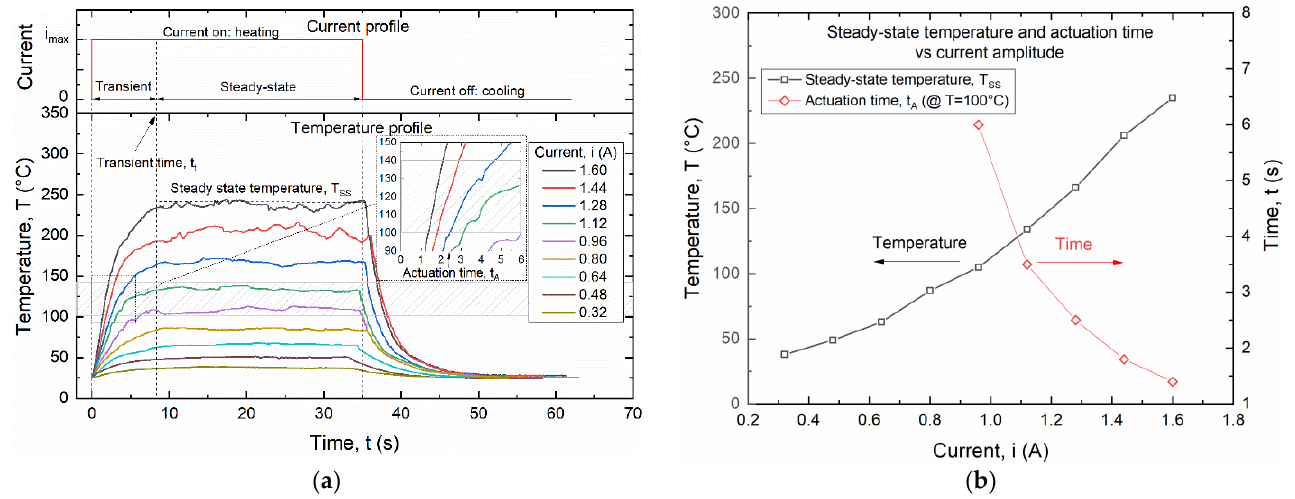
Figure 9. Temperature evolution of the SMA wire for a square current signal with a pulse duration of 35 s: ( a ) time evolution of the wire for different current amplitudes; ( b ) steady-state temperature (T SS ) and actuation time (t A ) versus current amplitude.